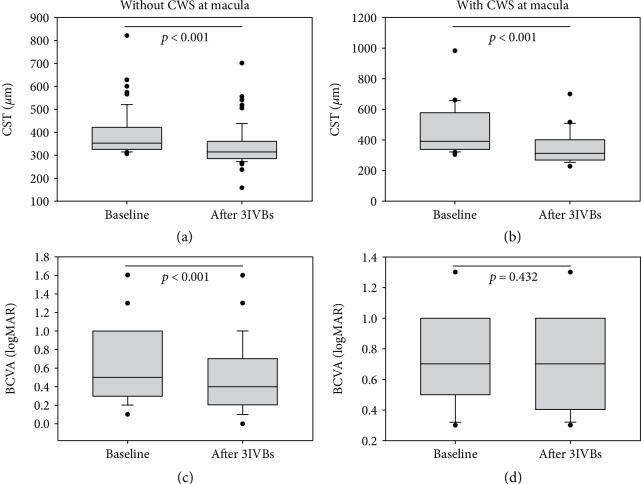
Box and whisker plots for central subfield thickness (CST) and changes in best-corrected visual acuity (BCVA) in patients with diabetic macular edema, with or without cotton-wool spots (CWS), after three consecutive monthly intravitreal bevacizumab (IVB) injections. The circles represent outliers. (a, b) The CST was significantly reduced after IVB injections in both groups (all, p < 0.001). (c, d) The BCVA improved significantly after IVB injection in the group without CWS, but did not significantly change in the group with CWS (p < 0.001 and p = 0.432, respectively).